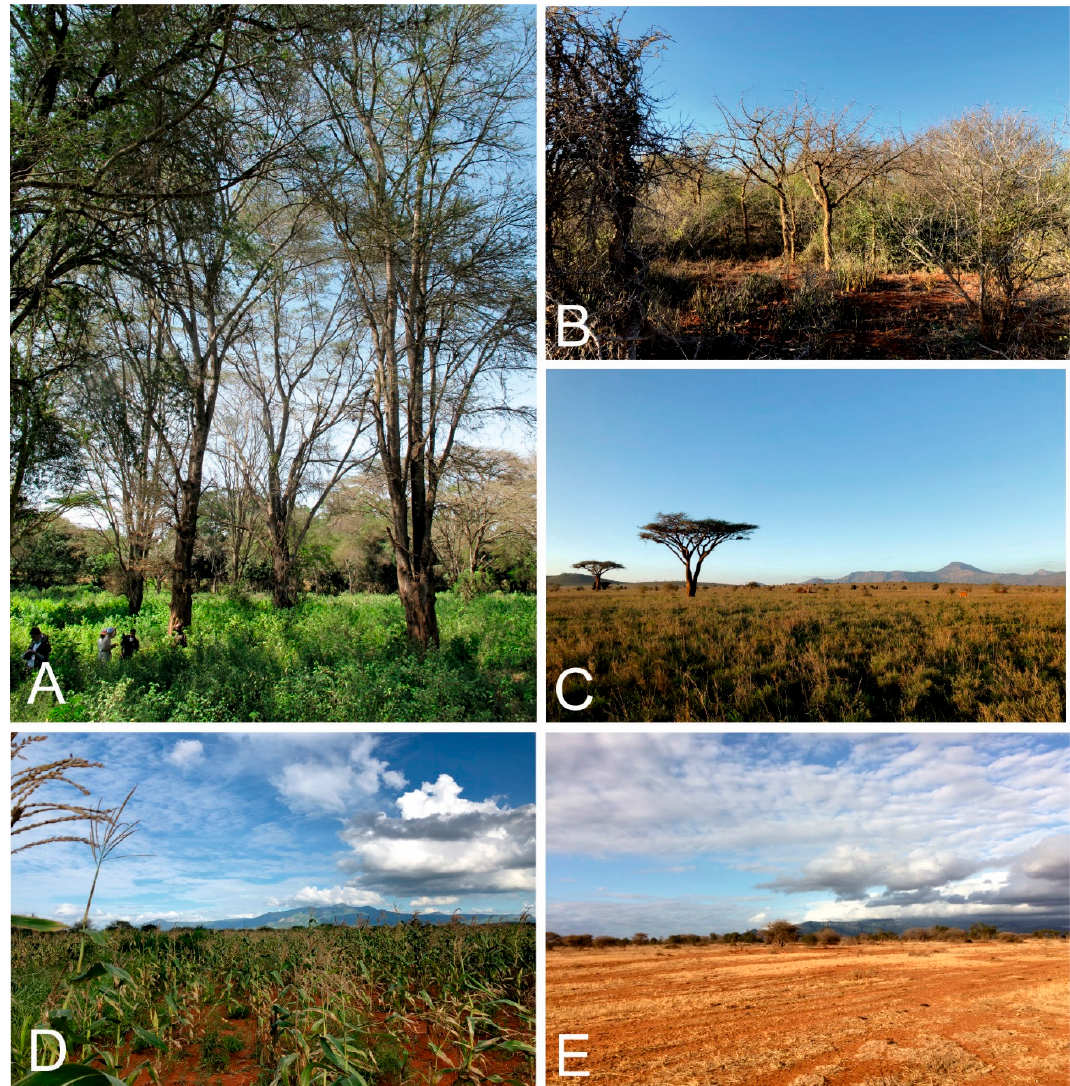
Figure 2. Land-use and land cover types in the study area. ( A ) Riverine forest characterized by Vachellia xanthophloea trees along the Bura River in THWS (J. Heiskanen, 27.8.2018). ( B ) Partly grazed Acacia-Commiphora bushland characterized by Vachellia tortillis and Commiphora baluensis in the matrix in Maktau (P. Pellikka 26.2.2019). ( C ) Grassland in the THWS conservation area with a Vachelia tortillis tree (P. Pellikka, 29.9.2018). ( D ) A maize ( Zea mays ) field next to Maktau weather station with Taita Hills in the background (P. Pellikka, 5.1.2020). ( E ) Degraded grassland in the livestock management area of West Mramba in LUMO (P. Pellikka, 16.8.2018).